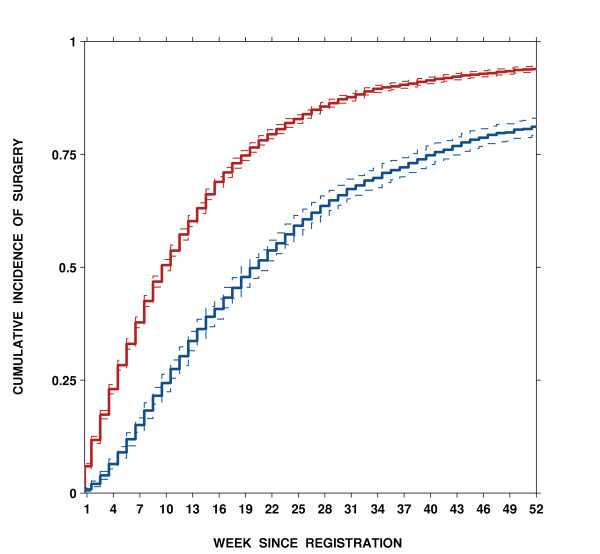
Estimated cumulative incidence of surgery and 95% CIs by week since registration in high-severity (red) and low-severity (blue) groups; two-sample test = 411.8, p < 0.001.